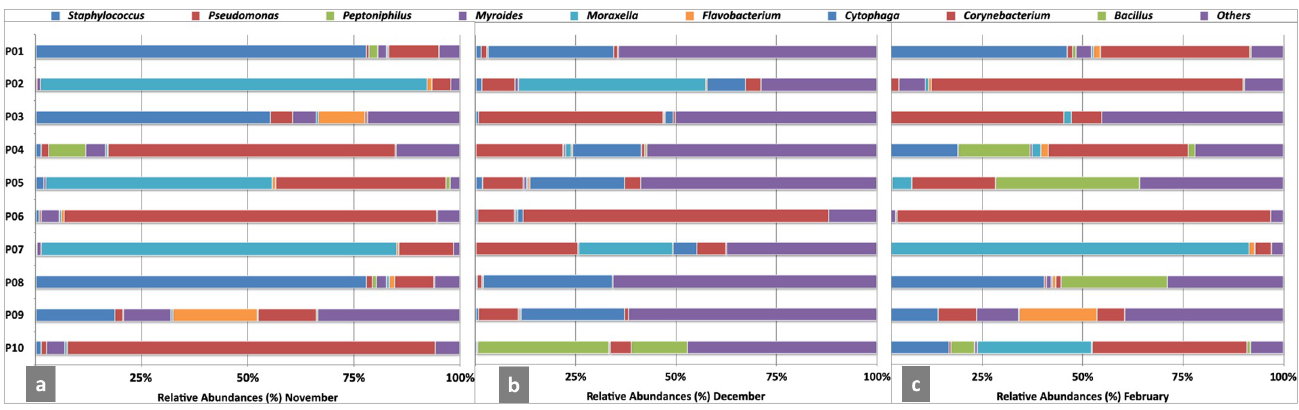
Fig 10. Intra-personal variations in the relative abundance of bacterial genera of the nasal cavities of the health care professionals sampled consistently for three months. P01-P10 on the Y-axis represents the ten individuals. The stacked bar shows the top ten genera with RA > 1.0% in each individual and the corresponding RA are plotted on the X-axis. All the genera with RA < 1.0% are collectively presented as Others.